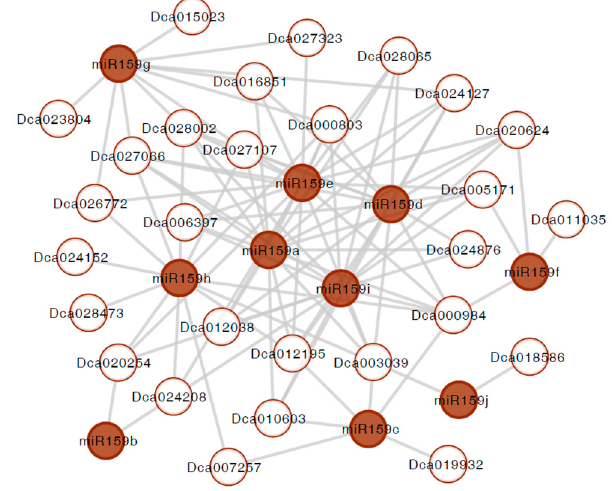
Figure 4. The network of Dof-miR159 gene family and their predicted target genes. The grey line between Dof-miR159s and predicted target genes represented the targeted relationship.